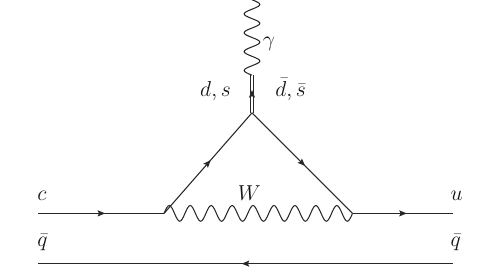
Fig. 2 The typical VME diagram via the penguin-like c → u γ tran-